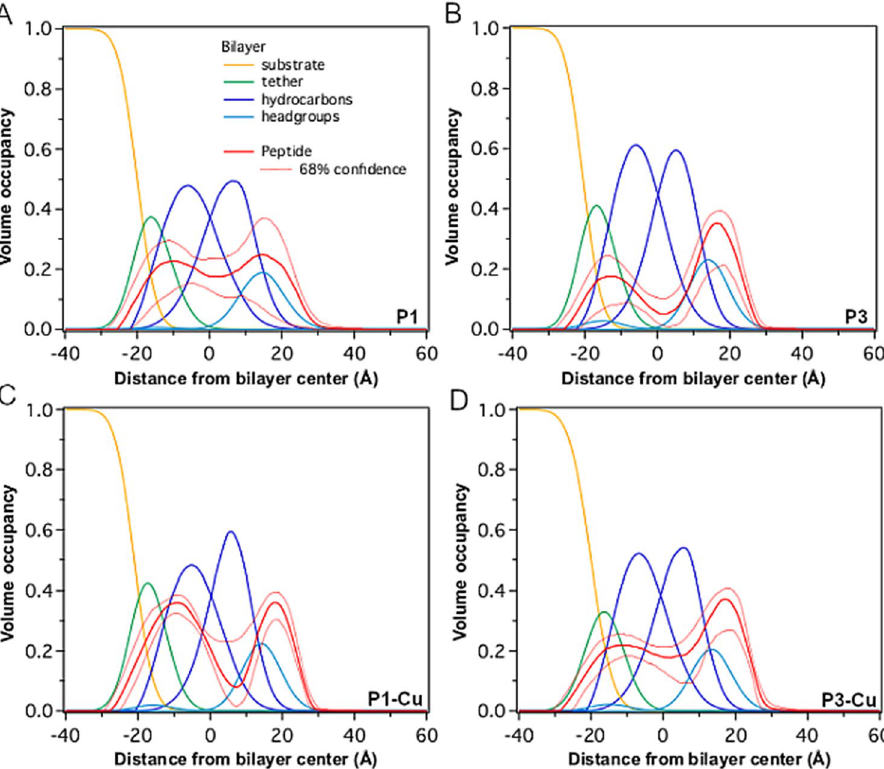
Figure 4. Neutron reflectometry of P1 and P3 in the apo- and holo-states. The time and ensemble average spatial profiles of the various components of the tBLM (Fig. 2A) are shown as projections on the normal to the bilayer surface for ( A ) P1, ( B ) P3, ( C ) P1-Cu 2+ , and ( D ) P3-Cu 2+ . The peptides were metallated using a 1:1 stoichiometric amount of CuCl 2 . The inner bilayer leaflet is attached to the gold coated substrate (yellow) via molecular tethers (green). The outer leaflet of the bilayer is exposed to the aqueous compartment from which each peptide solution is